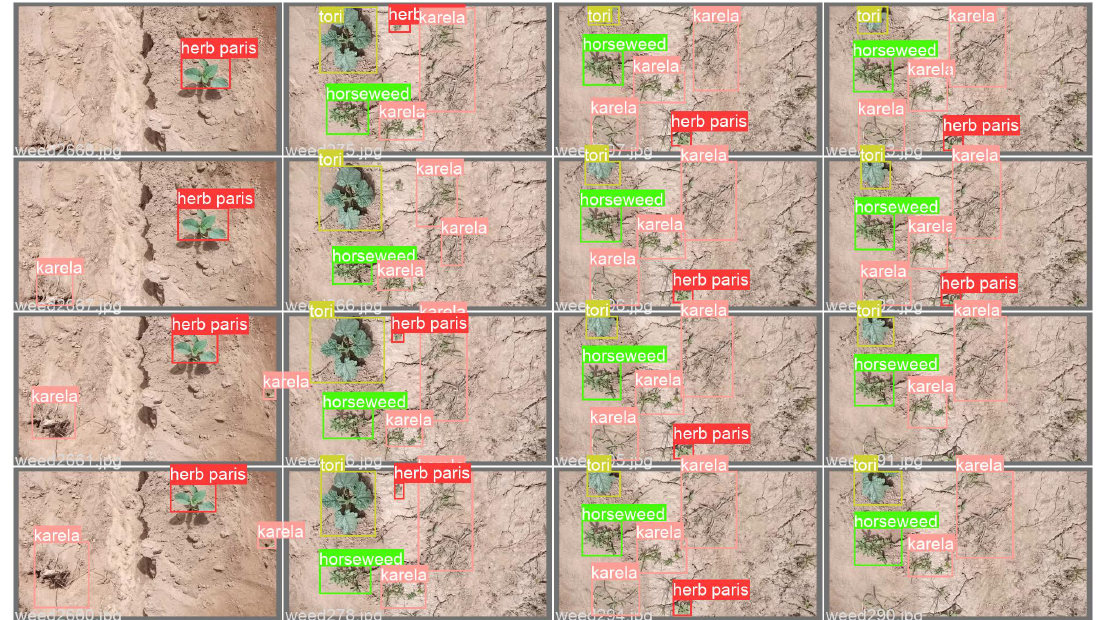
Figure 9. Computer Vision model correctly identifying crop and weed